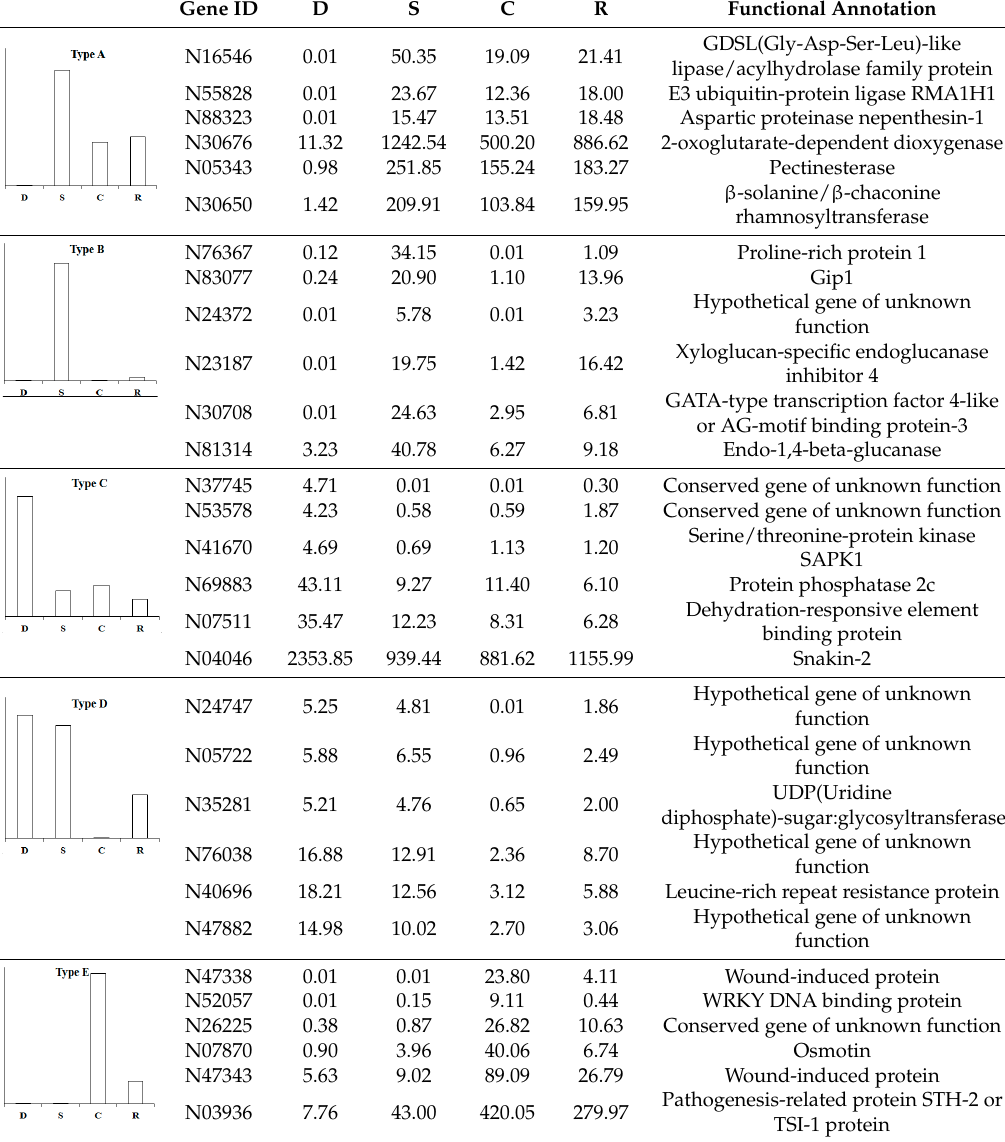
Table 2. Five typical expression profiles of DEGs in four samples. D: dormancy; S: sprouting: C: camphor inhibition; R: recovery sprouting.